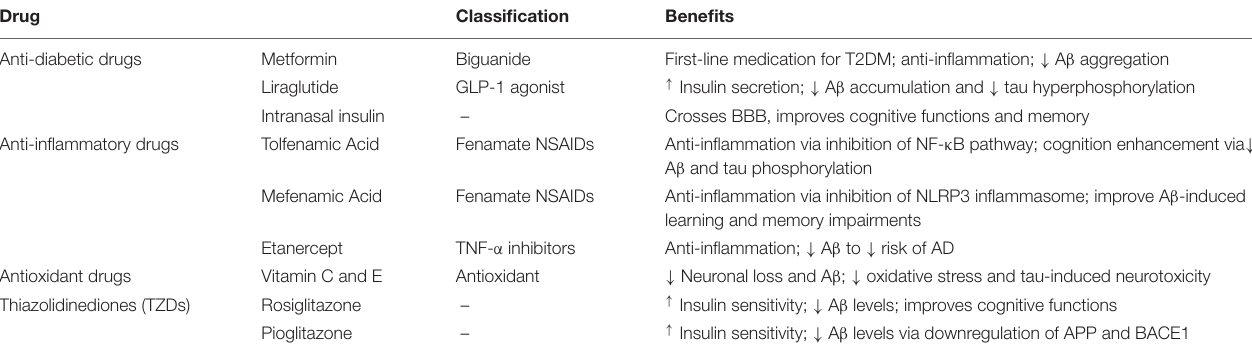
TABLE 1 | Various potential treatments for Alzheimer’s disease with insulin